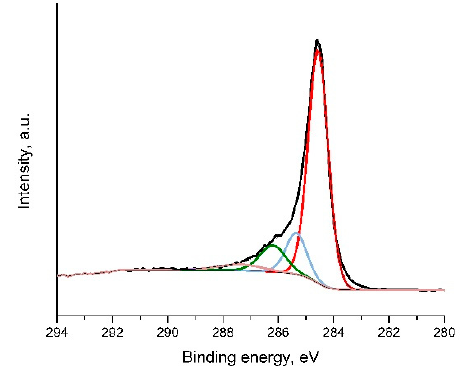
Figure A3. C1s spectra (XPS) of thermally reduced graphene oxide TRGO1.